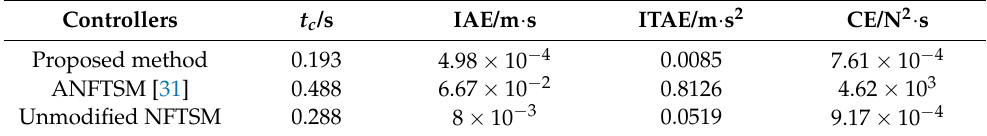
Table 2. Controller simulation